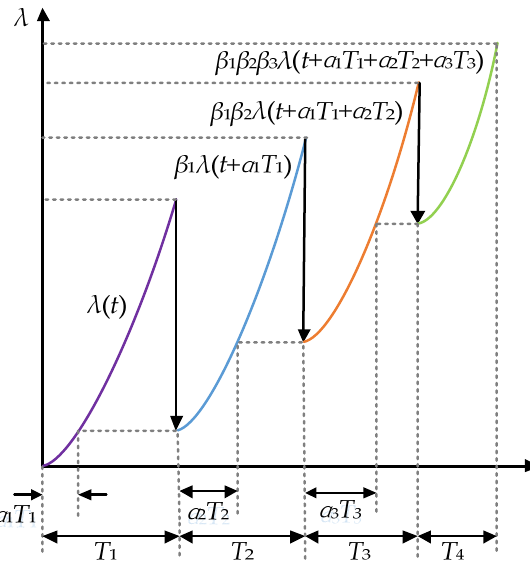
Figure 4. Evolution law of fault